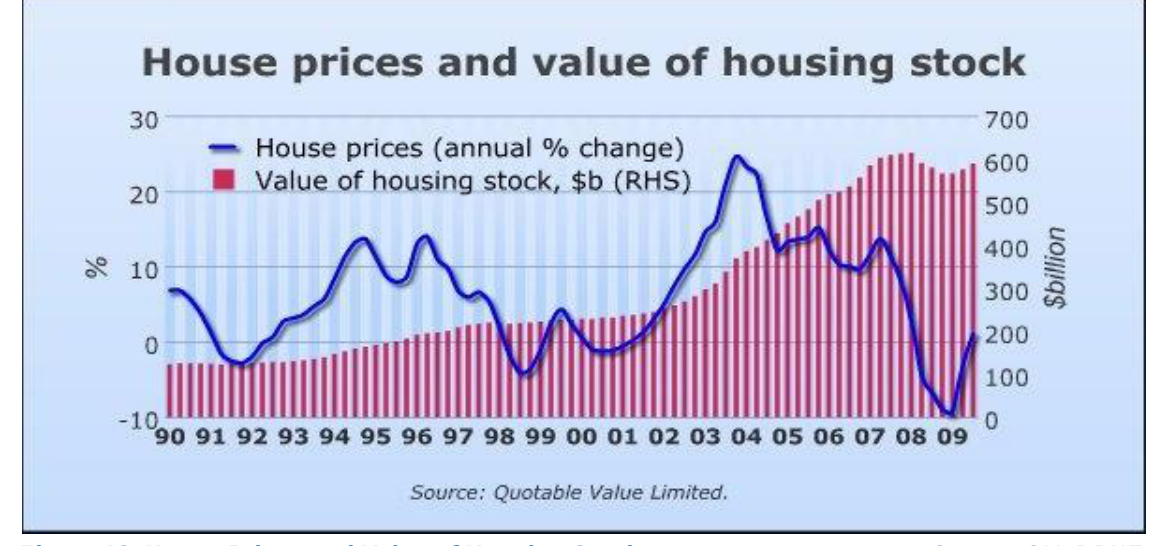
Figure 12 House Prices and Value of Housing Stock Source: QV,